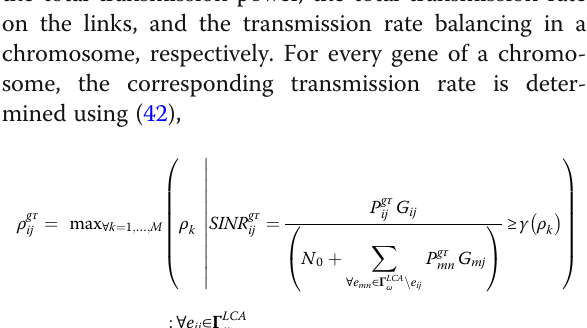
maximum values of transmission power, transmission rate and variance of transmission rate, respectively. These values are obtained using (44) and (45),